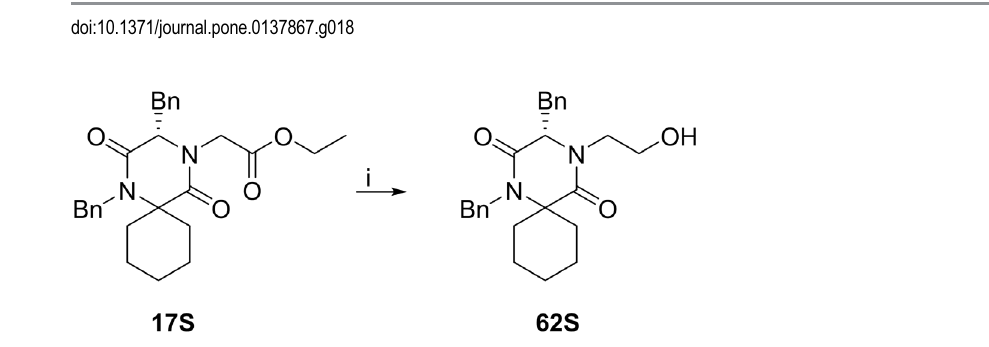
Fig 19. Reduction of 17S. Reagents and reaction conditions: i) NaBH 4 (3.0 eq.), EtOH, r.t., 5 days.